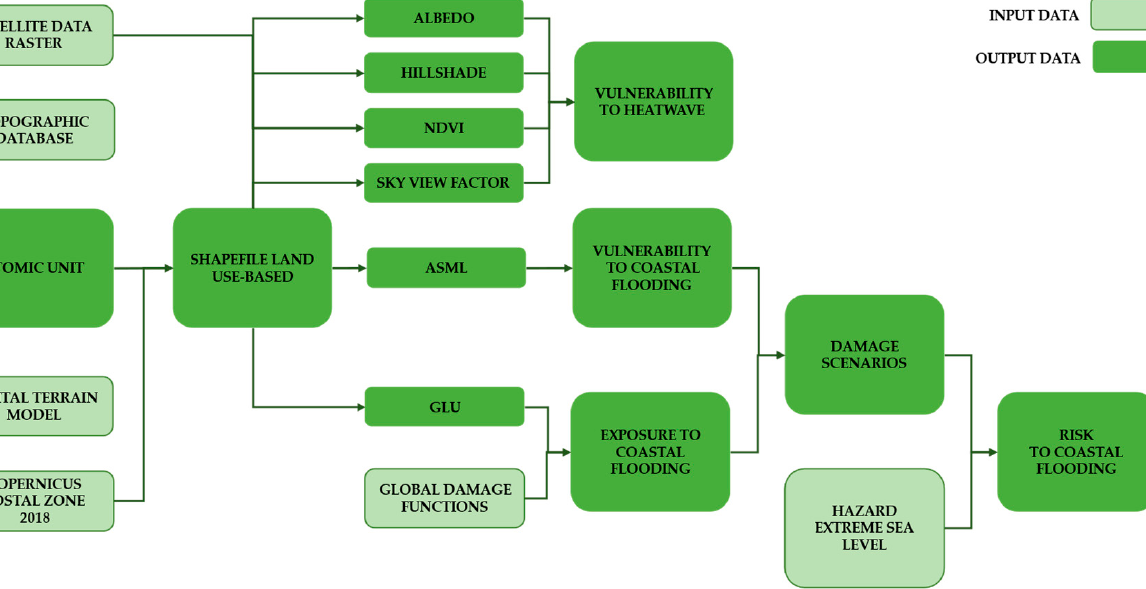
Figure 4. Workflow of the framework.